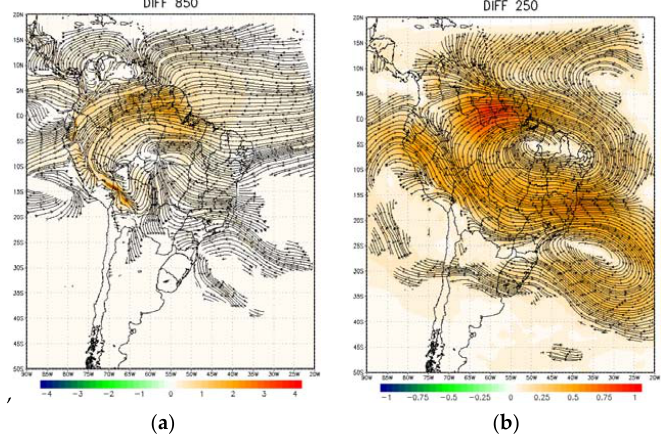
Figure 6. Difference (LUC minus CTRL) of annual mean (1980–2009) wind (streamlines and intensity in shaded according bottom bars) in m s − 1 , ( a ) at 850 hPa ( b ) at 250 hPa.